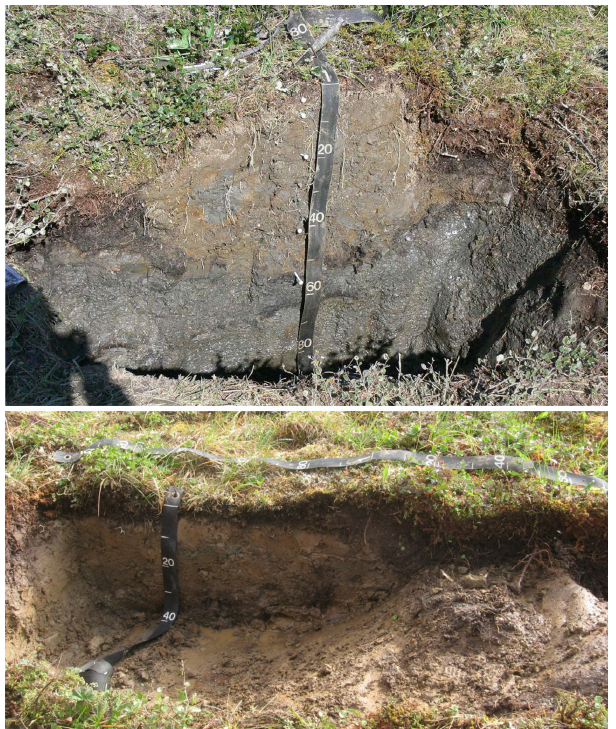
Figure 4. Cryoturbated soil profiles of the thawed active layers of an earth hummock (top) and a nonsorted circle (bottom). Note the distribution of organic matter in the low micro-topographic posi- tions and the insulating effect of the organic horizon on thaw